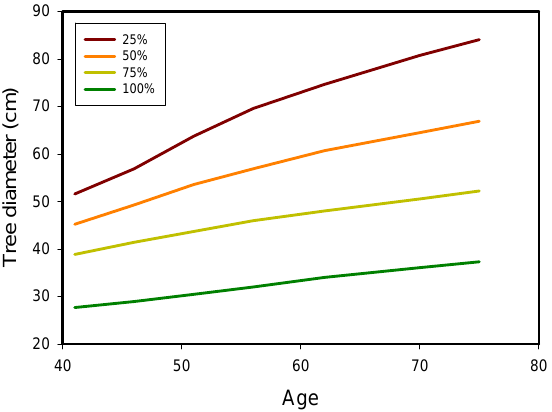
Figure 5. Quadratic mean diameter development with stand age from the Whiskey Springs thinning trial at Jackson Demonstration State Forest. Percent values refer to the residual basal area as compared to the value before thinning at age 40. Initial basal area was approximately 92 m 2 ha − 1 [87].